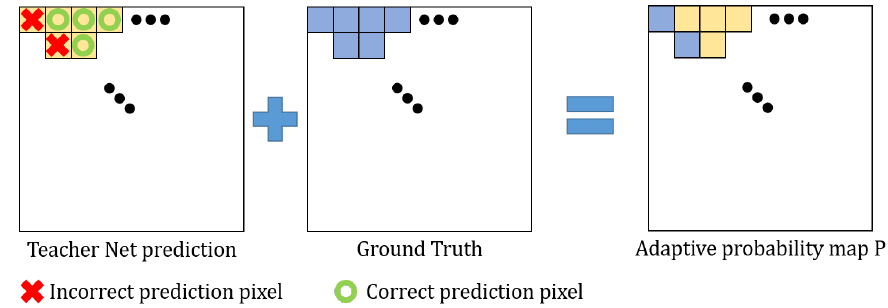
Figure 4. Illustration of generating an adaptive probability map. To generate the adaptive probability map, we check the teacher network prediction result as if it is a correct pixel. We use this new probability map for the proposed adaptive cross entropy (ACE) loss